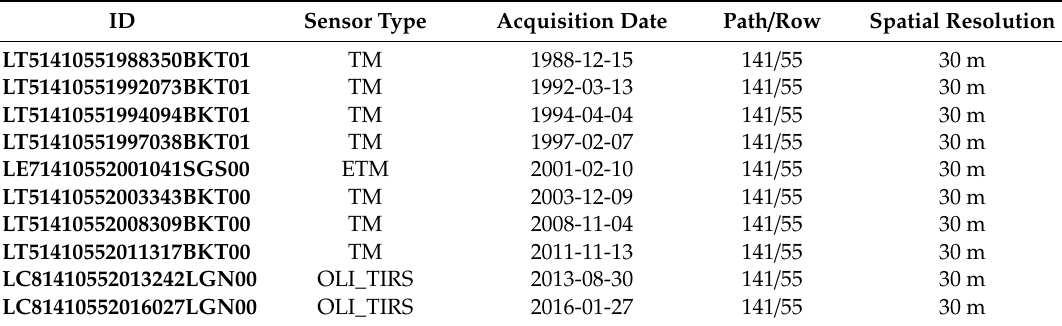
Table 1. Information about Landsat images used in this study.